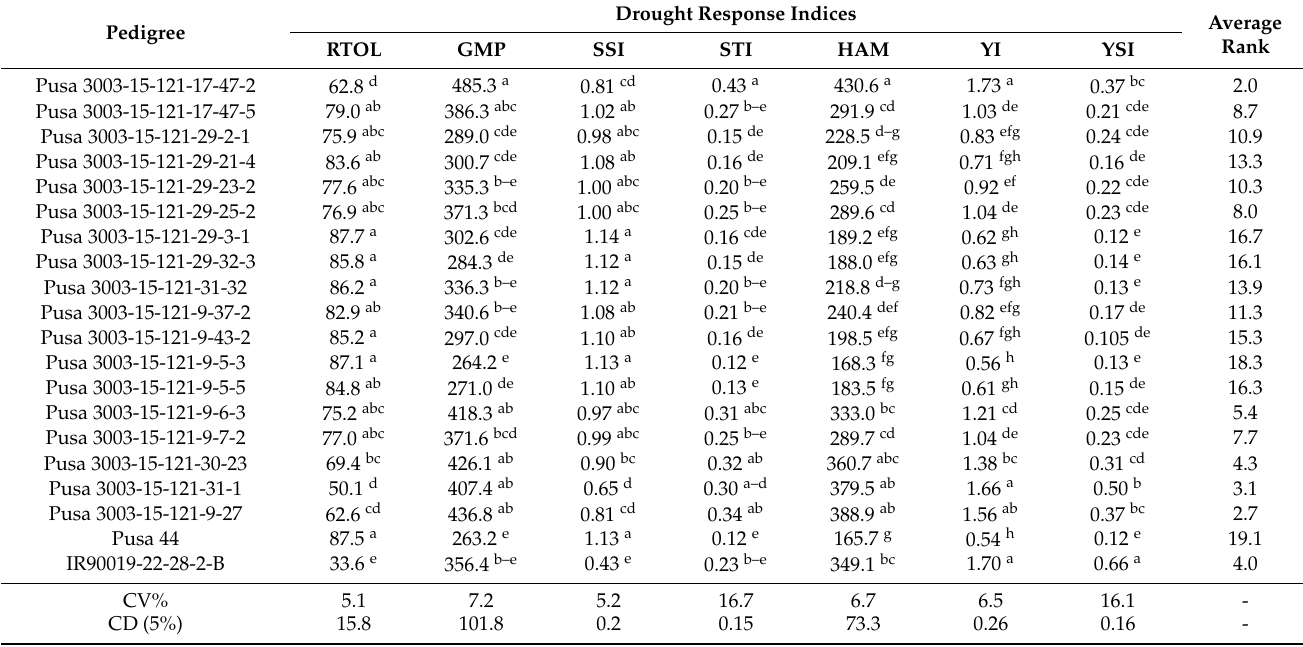
Table 6. Drought tolerance indices for Pusa 44 qDTY12.1 near isogenic lines based on the performance in Kharif 2019. Drought Response Indices Pedigree